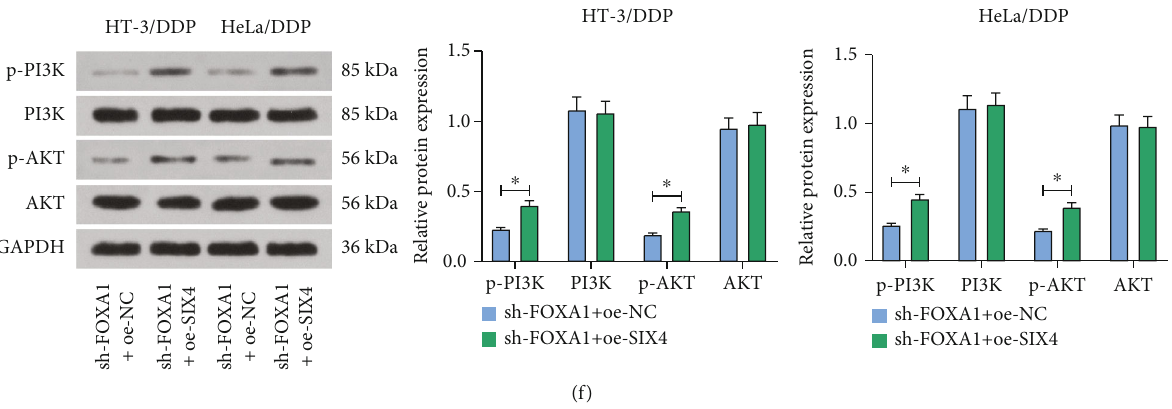
Figure 5: Overexpression of SIX4 partially reverses the inhibitory e ff ect of sh-FOXA1 on CC cell growth and chemoresistance. (a) Detection of mRNA expression of SIX4 in drug-resistant cells after cotransfection by RT-qPCR. (b) The proliferation of cells measured using colony formation assay. (c) The cell viability measured using EdU assay. (d) The invasive ability of cells determined using Transwell assay. (e) The chemoresistance of cells to DDP measured using MTT assay. (f) The protein expression of p-PI3K, PI3K, p-AKT, and AKT in cells examined using Western blot. Data among multiple groups were analyzed by two-way ANOVA followed by Tukey ’ s post hoc test ( ∗ p < 0 : 05 ; ∗∗ p < 0 : 01 ). The cell experiment was independently repeated three